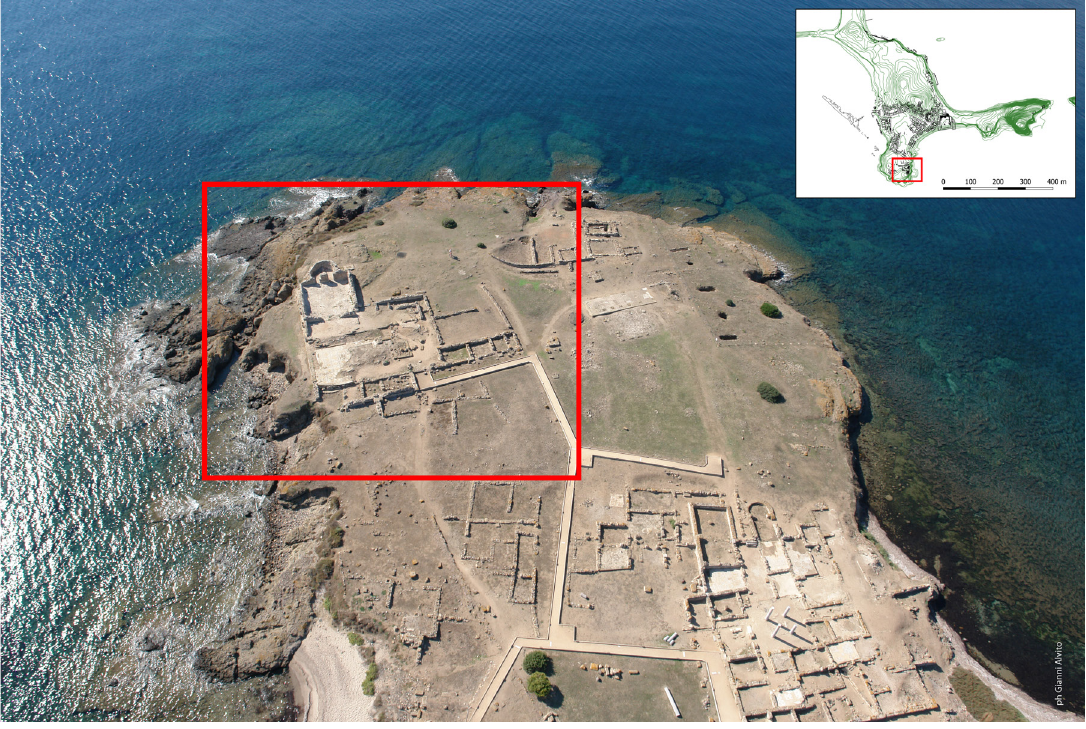
Figure 2. An aerial picture of the sanctuary of Aesculapius (in the red square). Image: G.